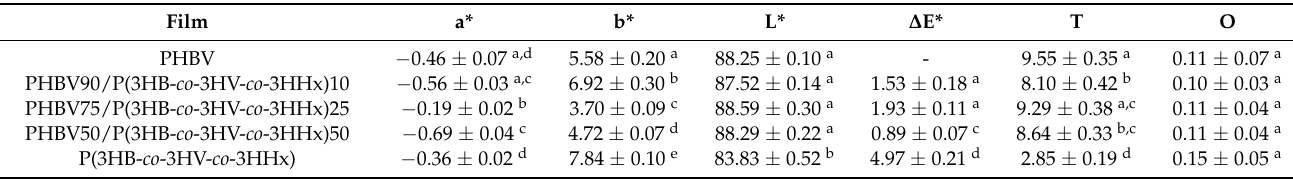
a*: Red/green coordinates (+a red, − a green); b*: Yellow/blue coordinates (+b yellow, − b blue); L*: Luminosity (+L luminous, − L dark); ∆ E*: Color differences; T: Transparency; O: Opacity. a–e Different letters in the same column indicate a significant difference among the samples ( p <